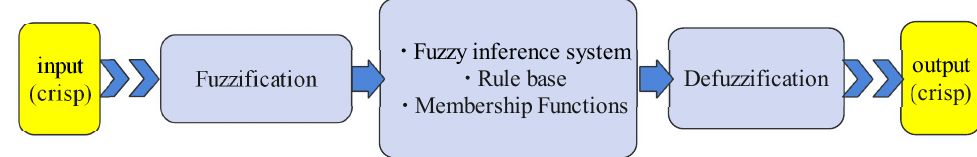
Figure 3. The basic stages in a fuzzy logic controller. The FLC was effectively used with different configuration for MPPT system [46,47].